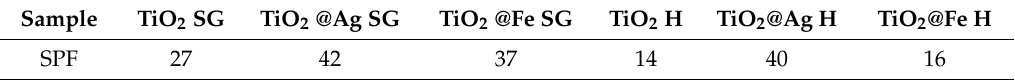
Table 3. SPF values of suspensions containing 5 wt.%